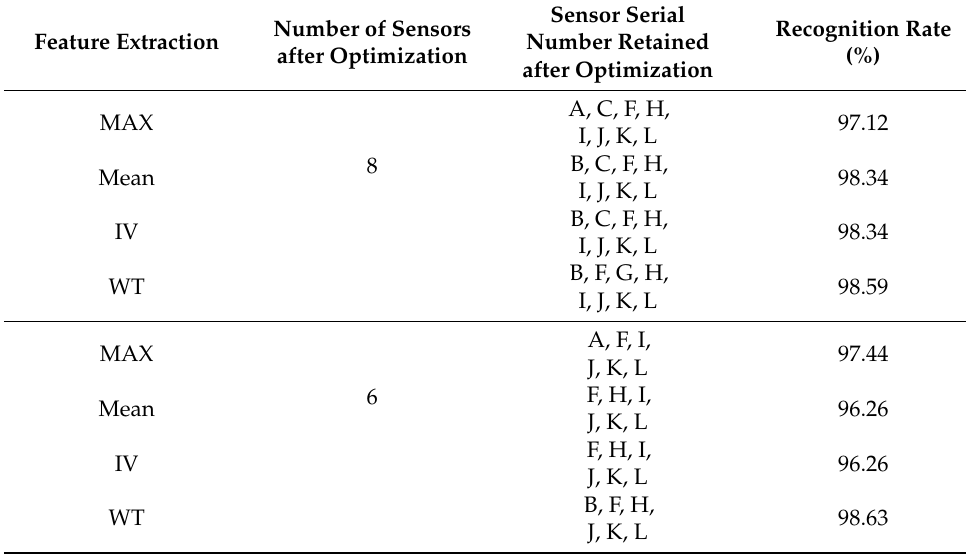
Table 4. The sensor array optimization results and the classification recognition rate based on RF after using PCA.